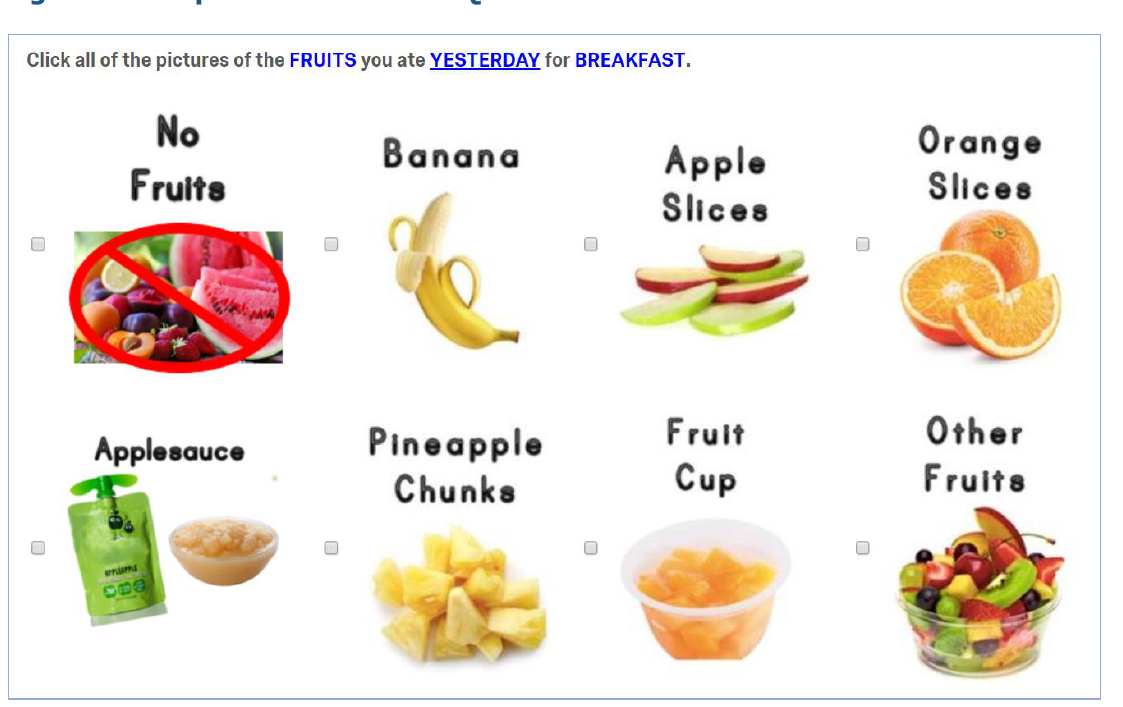
Figure 1. Sample CHAT Nutrition